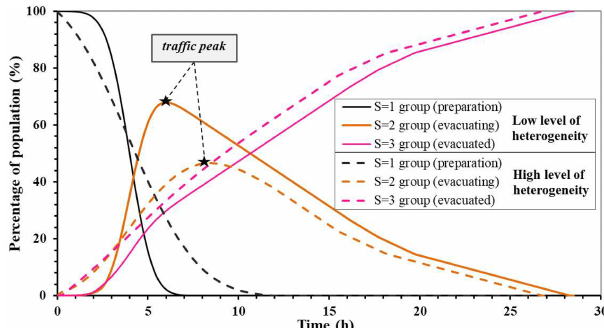
Figure 11. Comparison of the evacuation processes for low (solid lines) and high (dotted lines) levels of human behavioral hetero- geneity. Note that agents’ behavioral heterogeneity is measured by the standard deviation of their evacuation preparation time, and the low and high levels of heterogeneity are 1.0 and 3.0h, respectively.